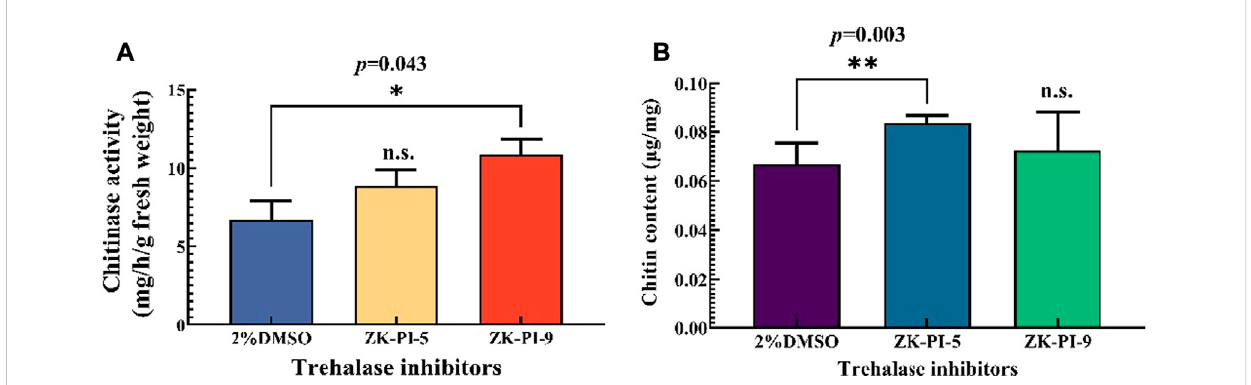
FIGURE 4 Changes in chitinase activity (A) and chitin content (B) 48 h after injection of two trehalase inhibitors. Values are presented as the means ± SE. * p < 0.05 denotes signi fi cant differences. ** p < 0.01 denotes extremely signi fi cant differences, n.s.: not signi fi cant (independent-samples t -test).